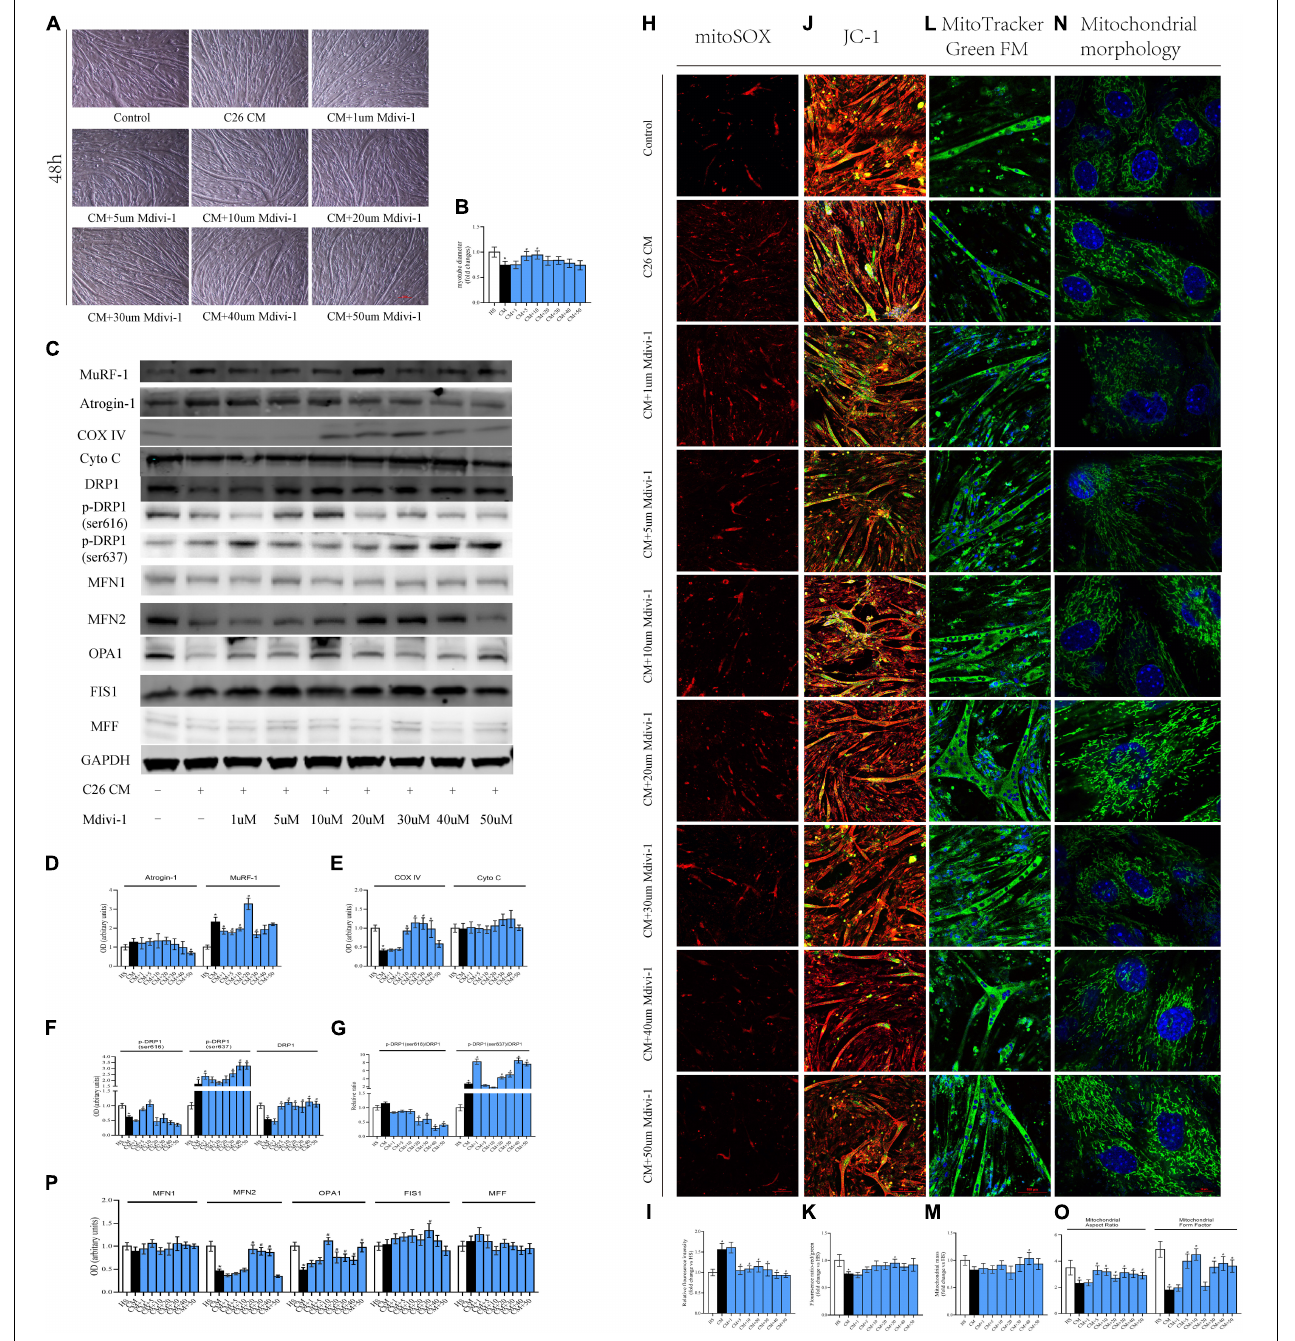
FIGURE 5 | (A) Typical images of C2C12 myotube cocultured with CM for 48 h. (B) Quantification of myotube diameter. (C) Levels of Atrogin-1, MuRF-1, DRP1, p-DRP1(ser616), p-DRP1(ser637), Cyto C, COX IV, and GAPDH by Western blot. (D) Quantification of Atrogin-1 and MuRF-1. (E) Quantification of Cyto C and COX IV. (F) Quantification of DRP1, p-DRP1(ser616), and p-DRP1(ser637). (G) Quantification of p-DRP1(ser616)/DRP1 and p-DRP1(ser637)/DRP1 ratio. (H) Typical images to analyze mitoROS by mitoSOX. (I) Quantification of mitoSOX with fluorescence ratio (Ex/Em = 510/580 nm). (J) Typical images to analyze MMP by JC-1. (K) Quantification of MMP with fluorescence intensity (red/green) ratio by ImageJ software. (L) Typical images to analyze mitochondrial mass by Mito-Tracker Green FM. (M) Quantification of mitochondrial mass with fluorescence intensity by ImageJ software. (N) Typical images to analyze mitochondrial morphology in myoblasts by MitoTracker Green FM. (O) Quantification of mitochondrial morphology by Mitochondrion Analyzer, a plugin of ImageJ software. FF (form factor: the reciprocal of circularity value) and AR (aspect ratio: major axis/minor axis of an ellipse equivalent to the object). (P) Quantification of MFN1, MFN2, OPA1, FIS1, and MFF; control: myotube cultured in DMEM of 2% HS CM (conditional medium): myotube cultured in DMEM of 33% C26 conditional medium; * p < 0.05 vs. control group; # p < 0.05 vs. CM group Data are displayed as mean ± standard deviation.